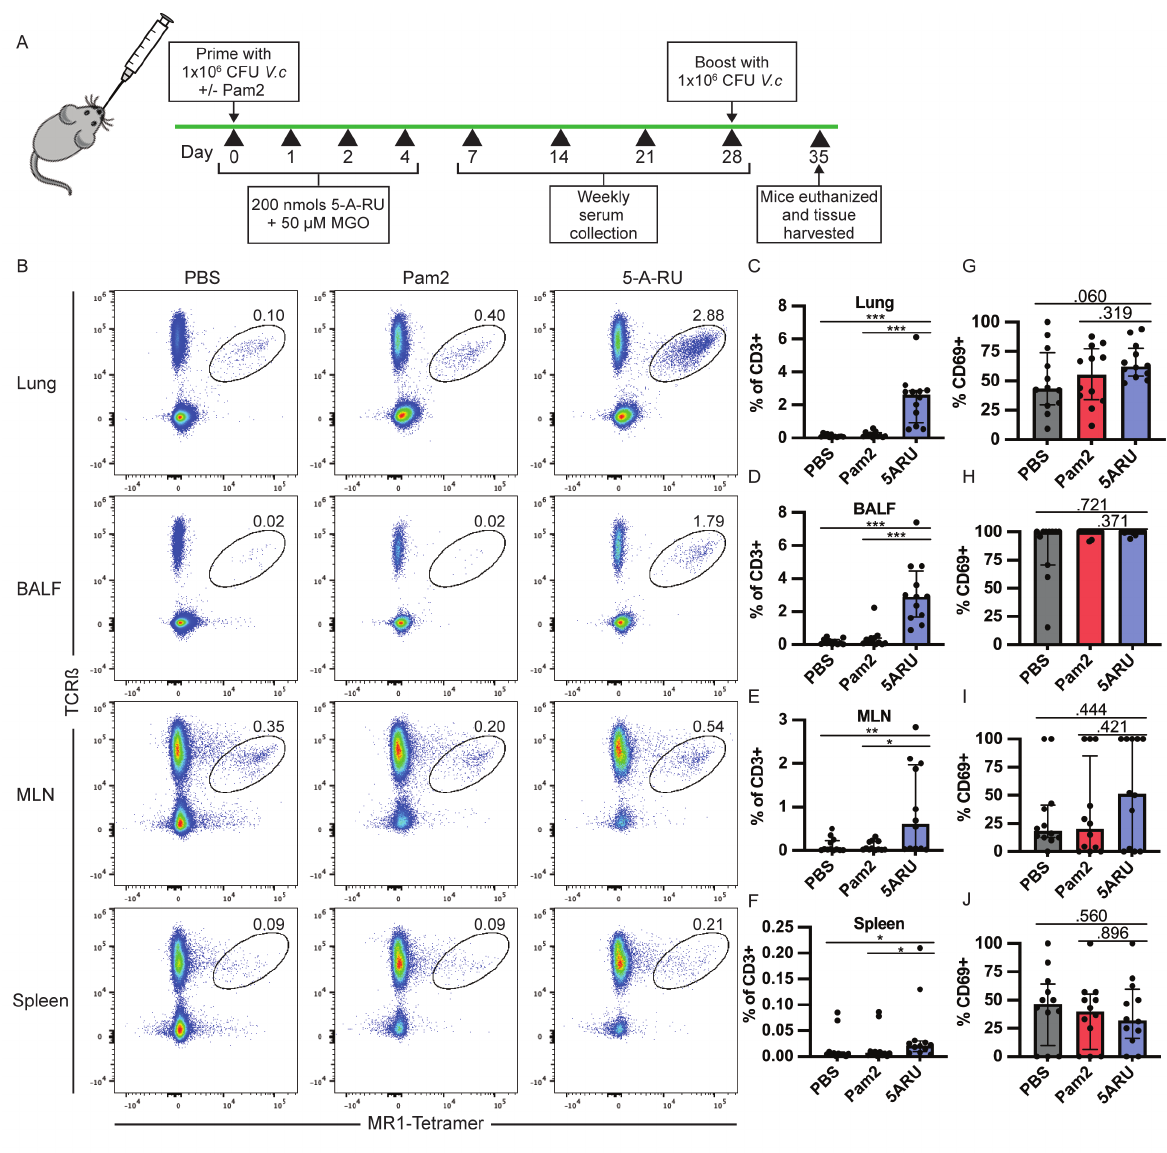
Figure 1. MAIT cells expand and persist in lungs and bronchoalveolar lavage fluid (BALF) following intranasal 5-A-RU treatment. ( A ) Live intranasal MAIT ligand plus V. cholerae O1 Inaba vaccination model timeline. ( B ) Representative FACS plots and ( C-F ) frequency as a percentage of CD3 + cells of MAIT cells (TCR b + MR1-Tetramer + ) from ( C ) lung, ( D ) BALF, ( E ) MLN, and ( F ) spleen gated on Live CD3 + CD19 - CD44 + cells. ( G-J ) Frequency of MAIT cells expressing CD69 in ( G ) lung, ( H ) BALF, ( I ) MLN, and ( J ) spleen. Data are represented as Median with IQR from 3 independent experiments. n=11-12 mice per group. * P < 0.05, ** P > 0.01, *** P > 0.001, *** P > 0.0001 by 2-tailed Mann-Whitney U